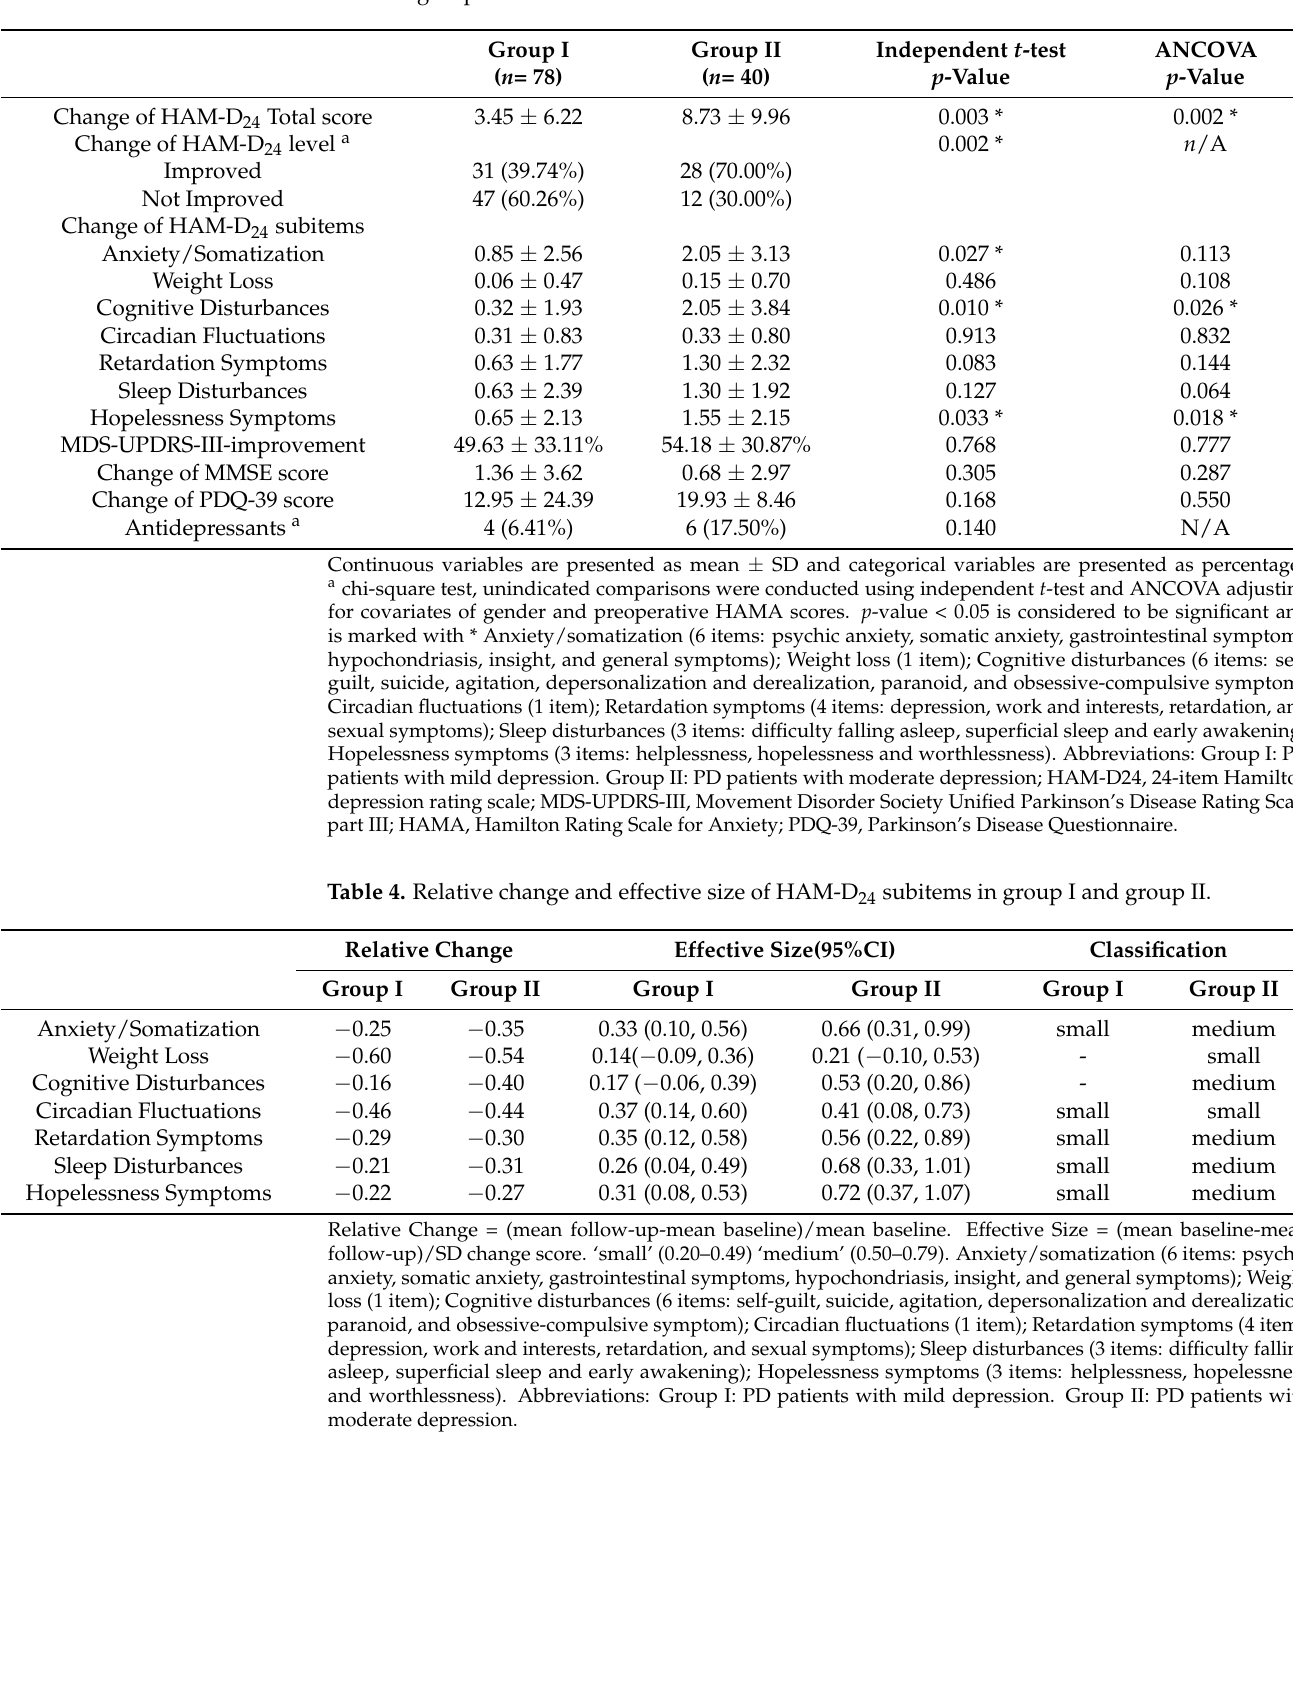
Table 3. Change of depressive symptoms, motor, cognition and quality of life after STN-DBS between groups.